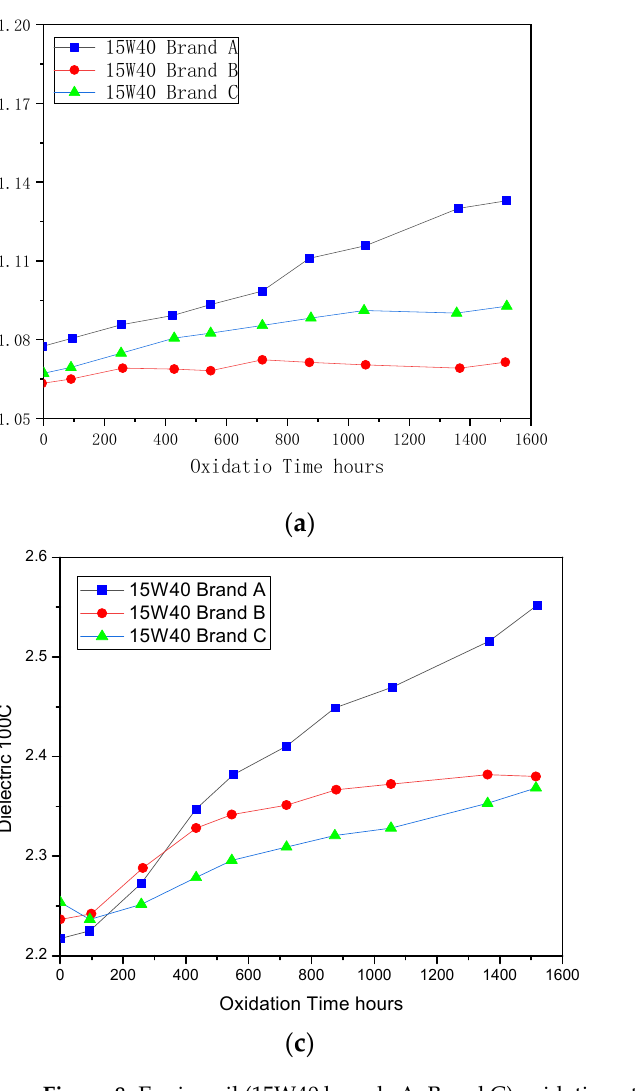
Figure 8. Engine oil (15W40 brands A, B and C) oxidation at 100 °C: ( a ) viscosity; ( b ) density; ( c ) dielectric; and ( d ) Rp.